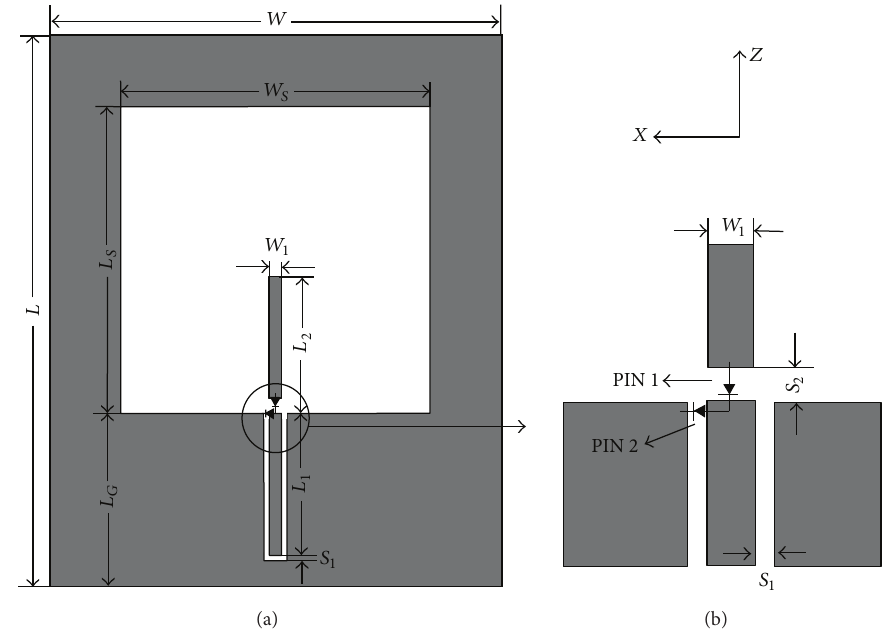
Figure 12: Geometry of a reconfigurable slot antenna [22].